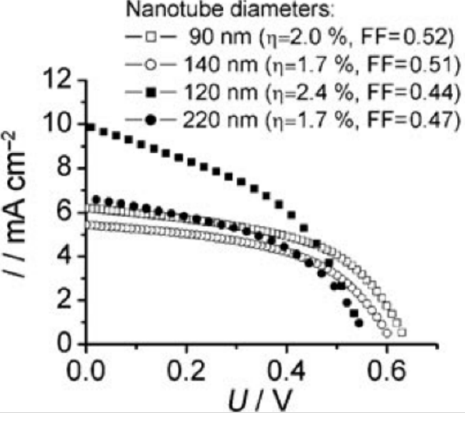
Figure 10. Current-voltage characteristics of DSSCs based on different diameter nanotubes (empty symbols correspond to 8 µm and filled symbols to 16 µm nanotube length). Reprinted with permission from [54]. Copyright 2009